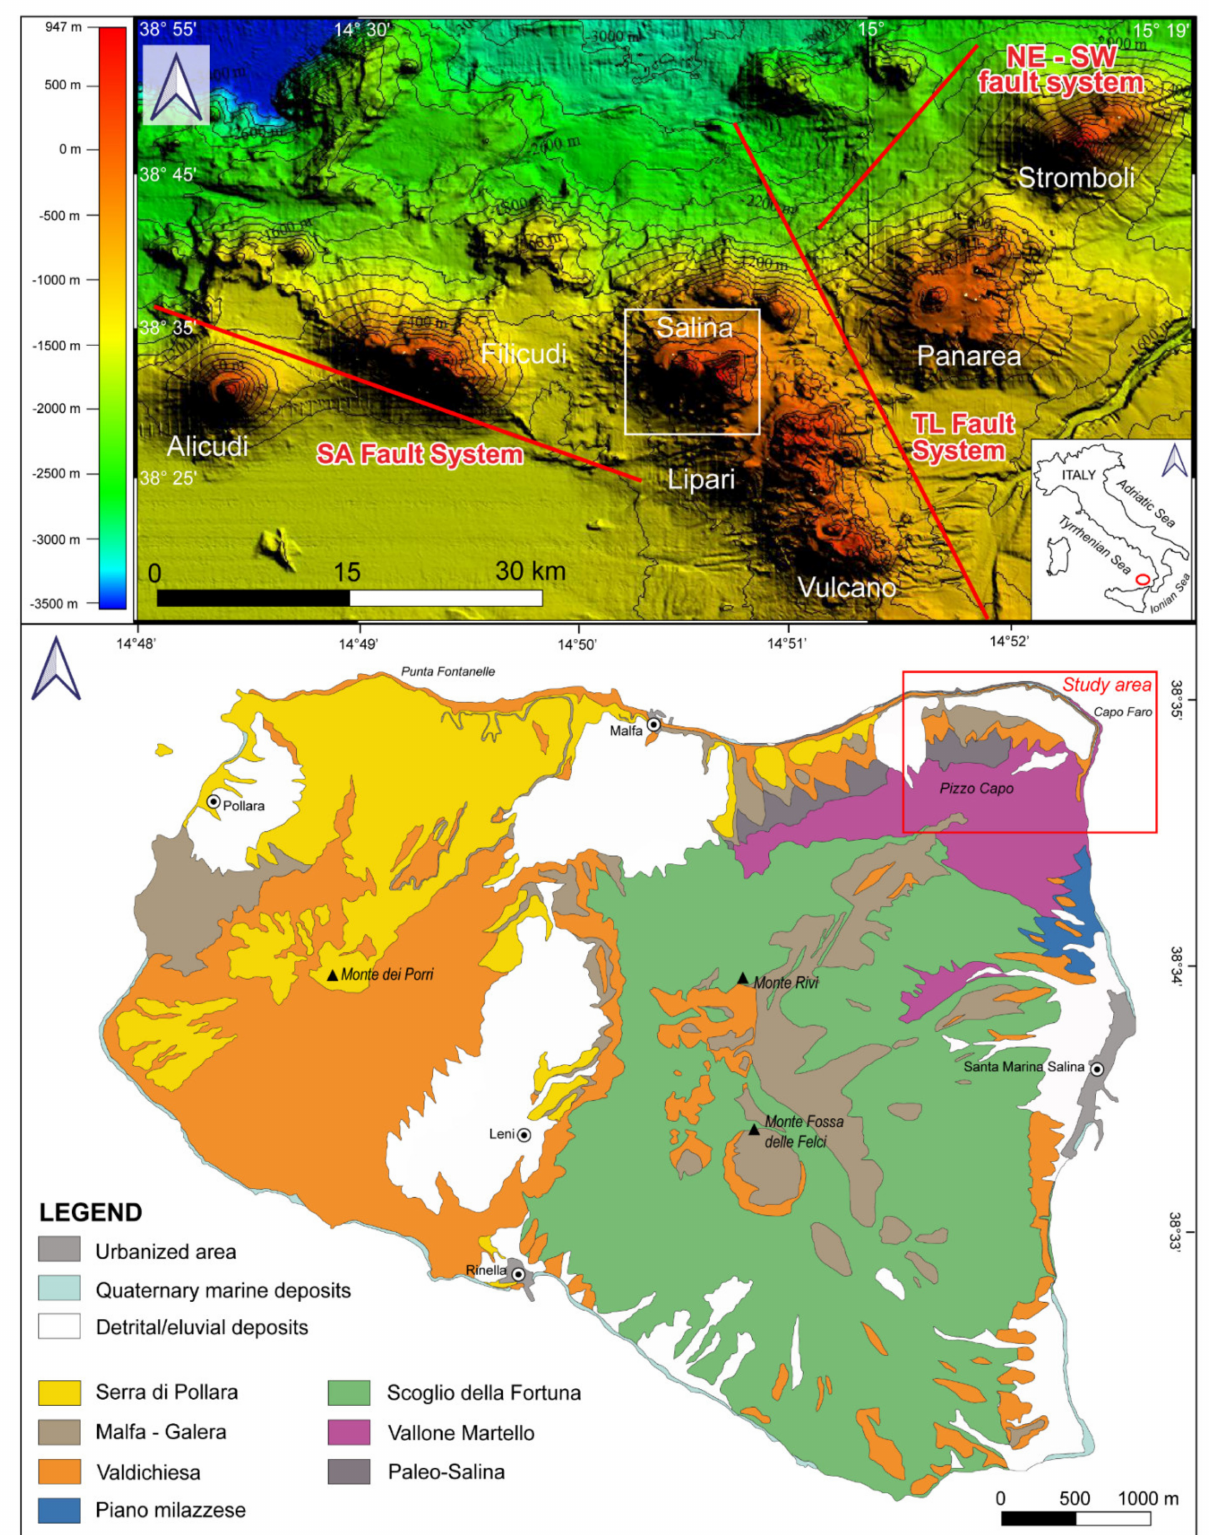
Figure 1. The geographical framework of the Aeolian Islands in the southern Italian peninsula in the upper panel. Salina is in the Central sector of the archipelago and is the subaerial expression of a mostly submerged volcanic system at the intersection between SA and TL fault systems. In the lower panel, simplified geological map with the main synthems of Salina Island (modified from